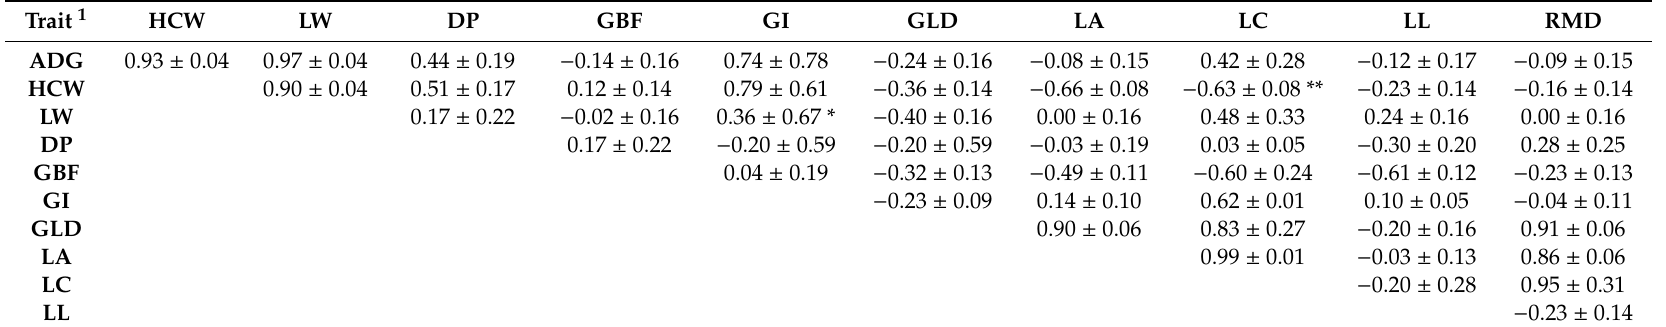
Table 11. Genetic correlations among growth and conventionally measured carcass traits.